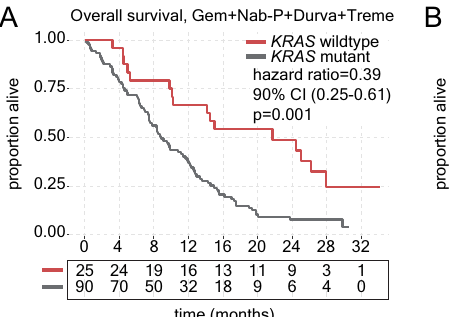
Fig.3|ctDNA-based KRAS mutationstatusishighlyprognosticinpatientswith mPDAC. A Kaplan-Meier curve comparing overall survival (OS) between patients with KRAS wildtype (red) versus mutant (grey) tumors in the gemcitabine, nab- paclitaxel, durvalumab and tremelimumab (Gem+Nab-P+Durva+Treme) treatment group. B Kaplan-Meier curve comparing OS between patients with KRAS wildtype